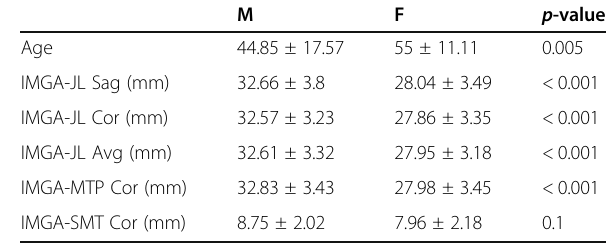
Table 2 Comparison between male and female